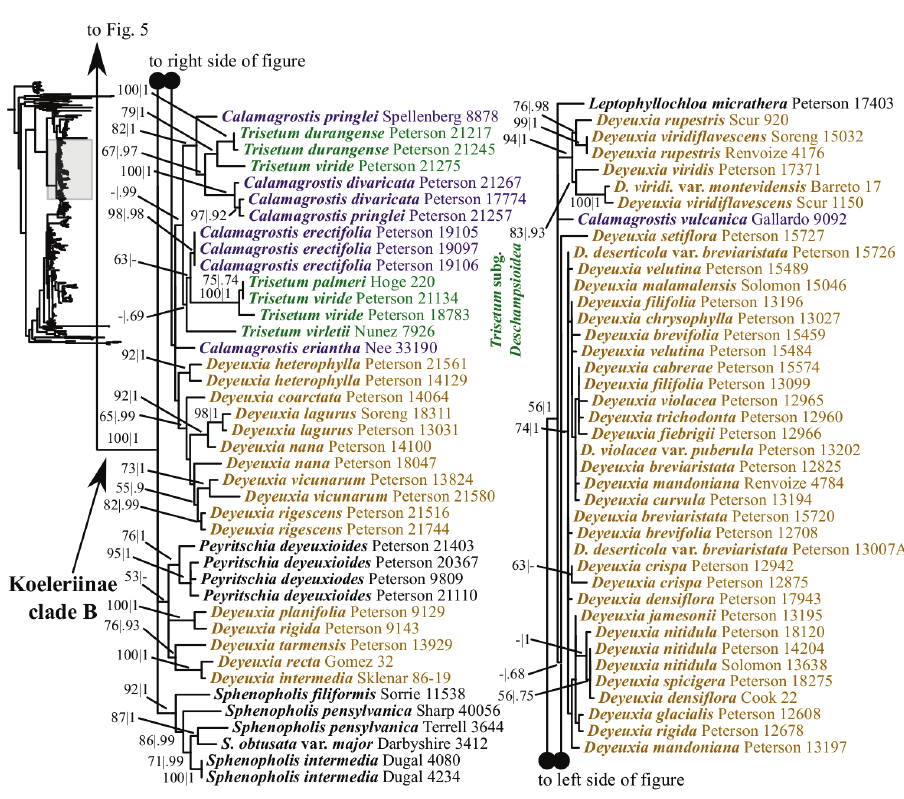
Figure 6. A portion (Koeleriinae clade B) of the maximum likelihood phylogram inferred from ITS+ETS data. ML bootstrap support (left) and BI poster probabilities (right) are recorded along branches. A dash indicates bootstrap support <50% or posterior probability <.5. No support is shown for branches with bootstrap support <50% and posterior probability <.5. The shaded area of the smaller tree on the left indicates the location in the overall tree of the portion